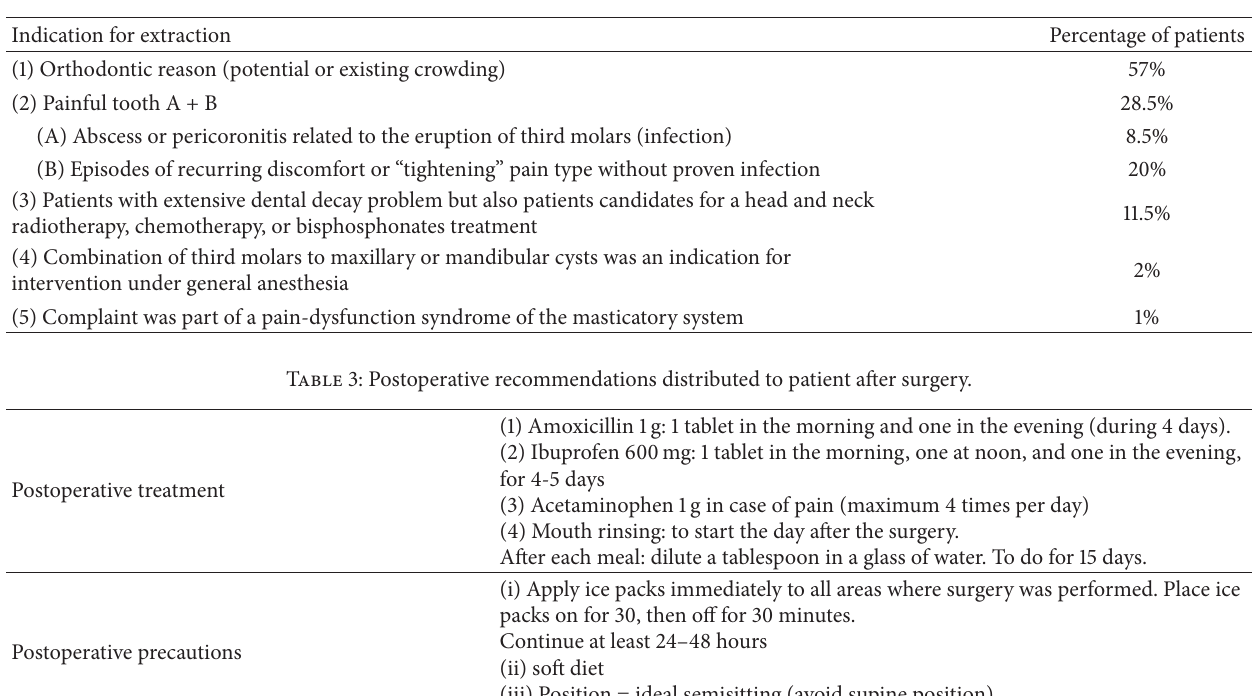
Table 2: Indications for extraction of the third molars.